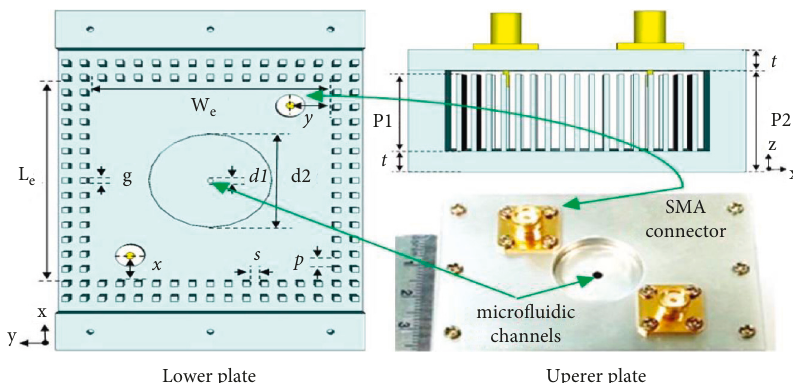
Figure 4: Structure of the proposed sensor.